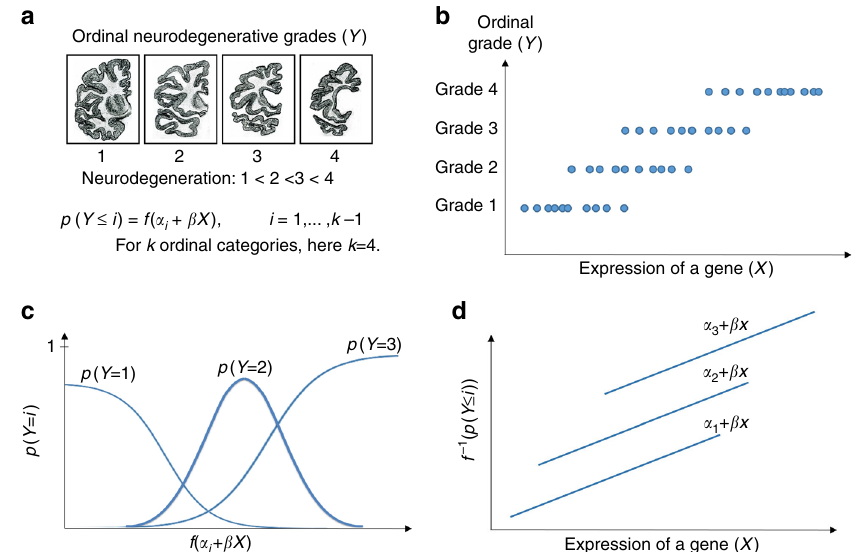
Fig. 1 Combining transcriptomic data with ordinal clinical information. a Schematic representation of postmortem brain tissues, which are categorized in four groups based on their degree of neurodegeneration. The formula shows an ordinal regression model in which the expression of a gene explains the degree of neuronal loss. This model is implemented using the proportional odds assumption, where the slope of the fi tted lines ( β ) is considered equal for all categories. b In this plot, the X axis shows the expression of a gene, while the Y axis shows neurodegenerative grades. Each dot represents the expression of a gene from a sample with neurodegenerative grade y . c The plot shows the ordinal regression model, in which a linear function of the expression of a gene is related to the probability of an ordinal category. d In this plot, the expression of a gene is represented in the X axis, while the Y axis shows a function of the cumulative probability of ordinal categories. The parallel lines display fi tted lines by implementing the proportional